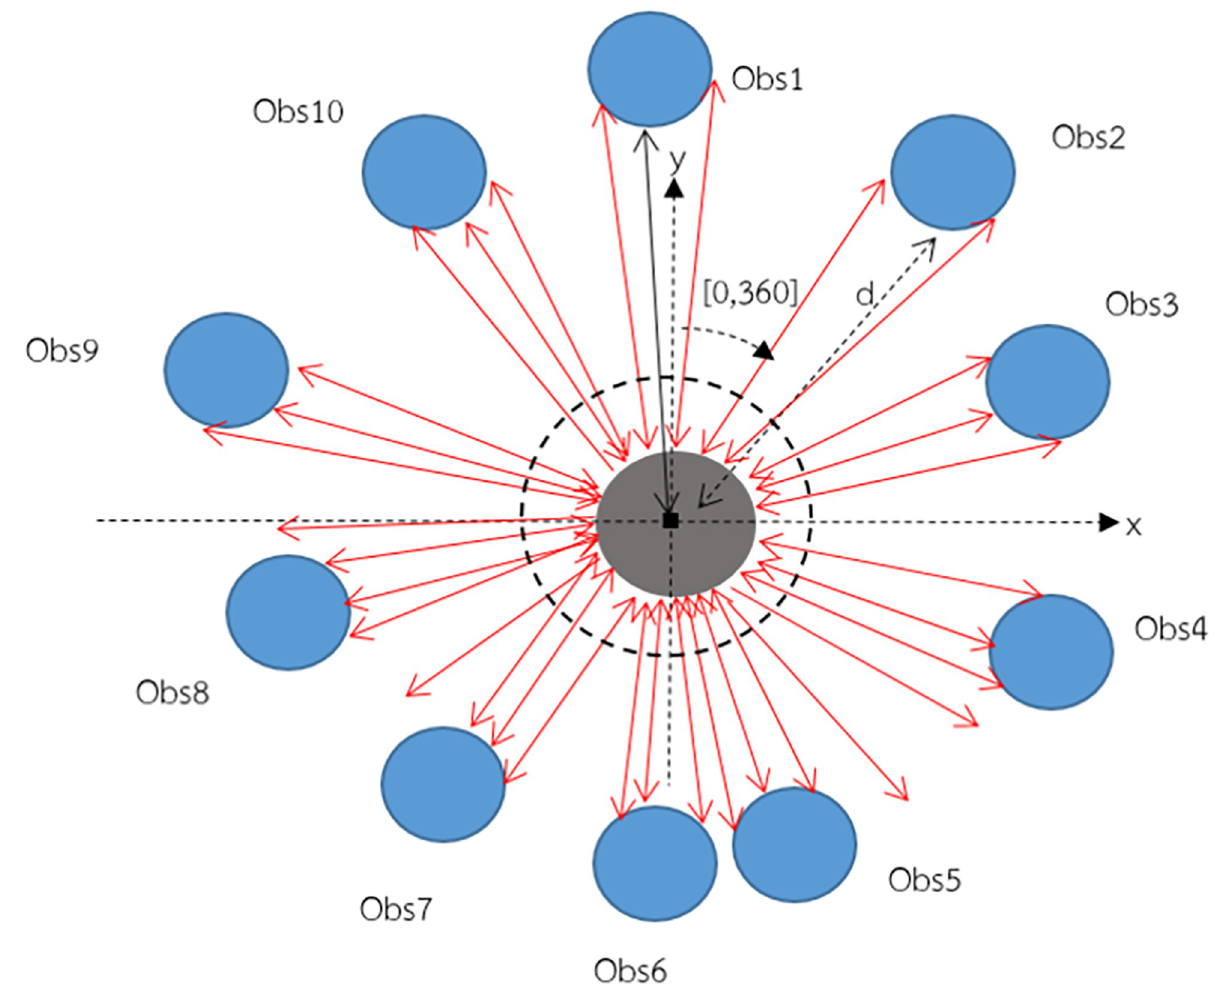
Fig 19. Determination of obstacle positions using